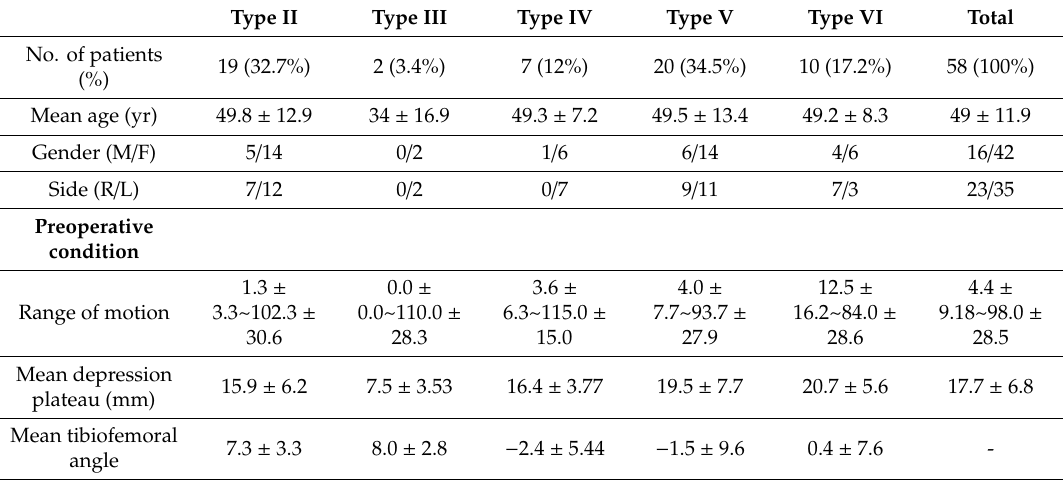
Table 1. Demographics of surgical patients: Schatzker classification of fracture types and associated soft-tissue